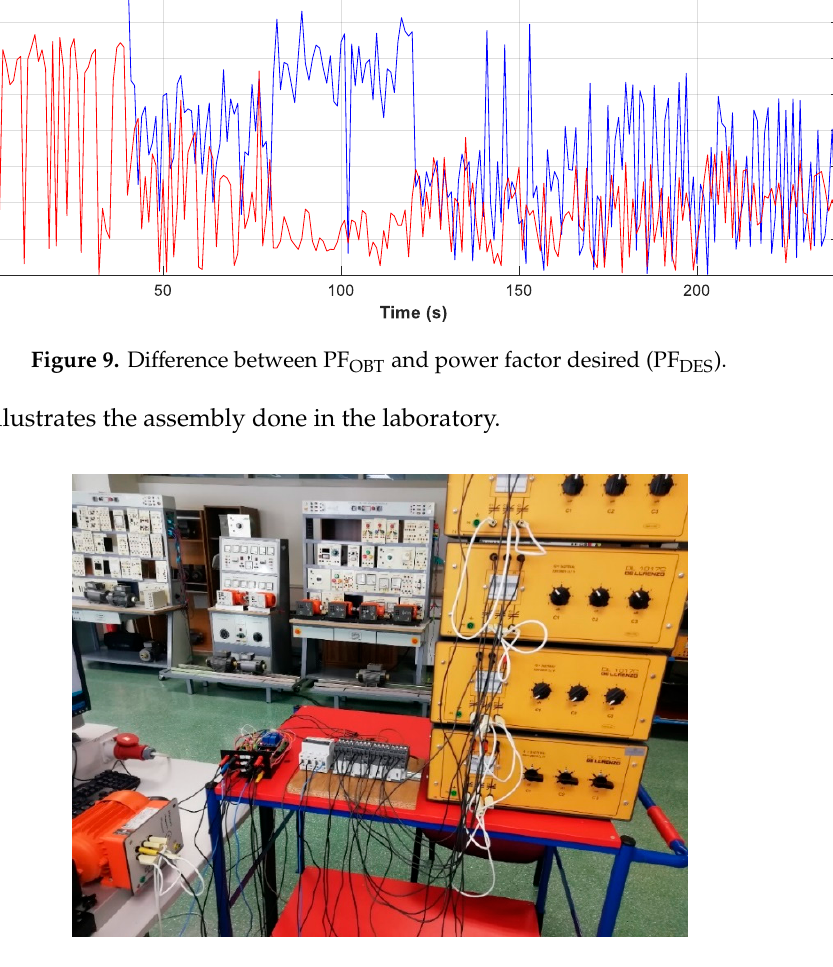
Figure 10. Final assembly for the study of the three phase motor load.